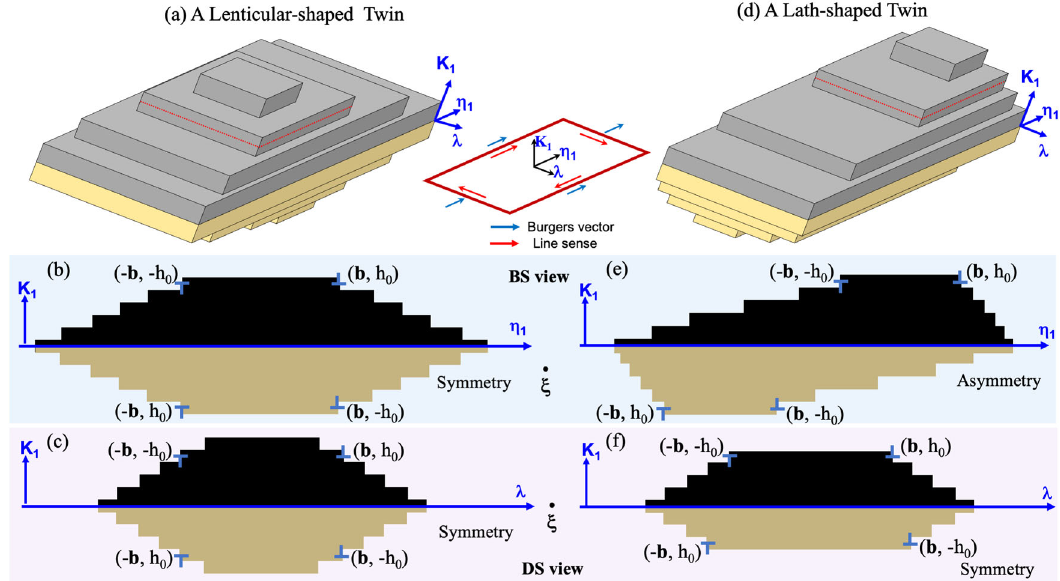
Fig. 1 Schematics of three-dimensional (3D) twin shapes. a Lenticular-shaped and d lath-shaped twins. Lenticular-shaped twin exhibits symmetric twin shape in b BS and c DS view. Lath-shaped twin exhibits an asymmetry twin shape in e BS view and quasi-symmetric twin shape in f DS